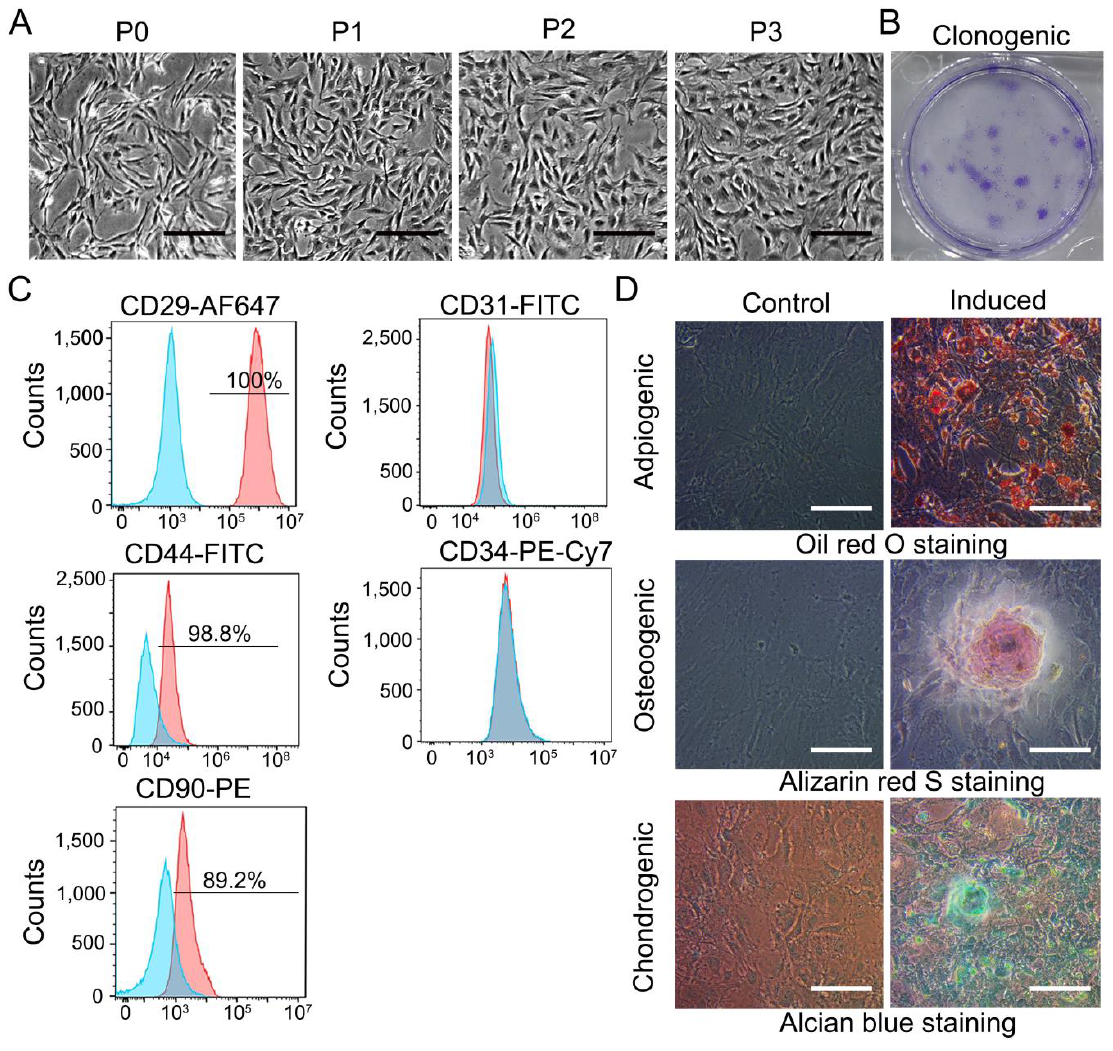
Figure 1. Characterization of TDSCs. ( A ) The cells presented spindly like. (Bar: 200 μm.) ( B ) Clonogenesis of TDSCs, using crystal violet staining. ( C ) TDSCs were positive for CD29, CD44, and CD90 but negative for CD31 and CD34. TDSCs, tendon-derived stem cells. ( D ) Adipogenesis, osteogenesis, cartilage-like, using Oil red O, Alizarin red S, and Alcian blue staining, respectively. Bar: 100 μm.